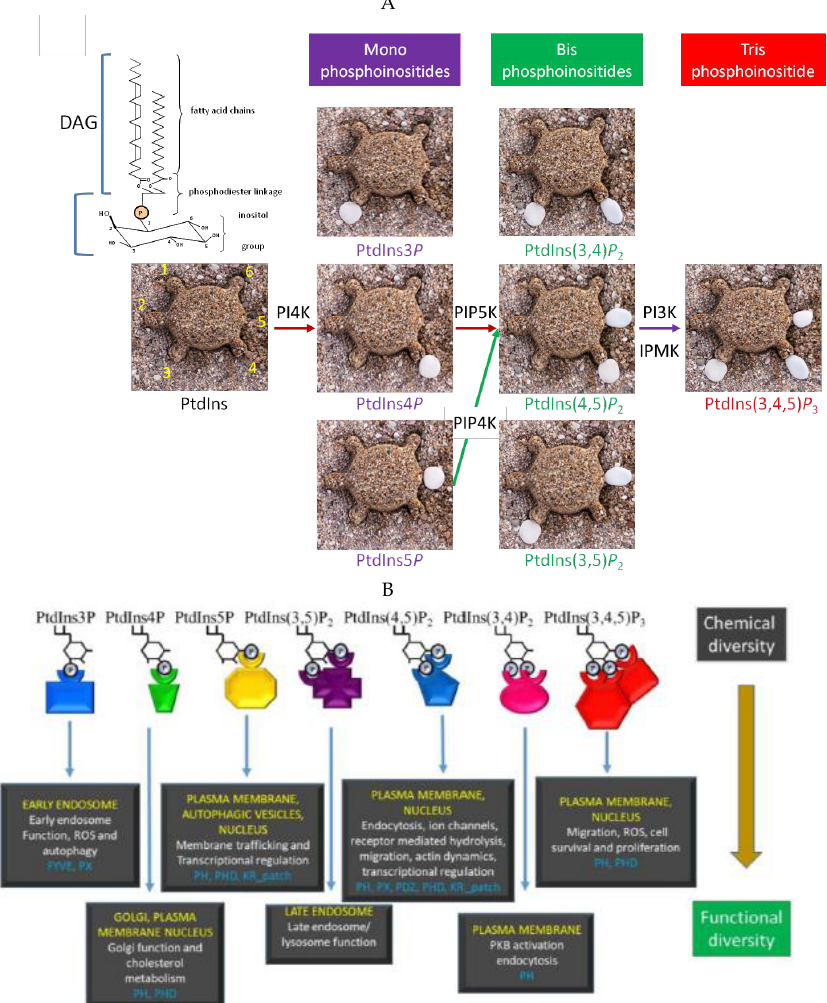
Figure 1. ( A ) The cartoon shows a representation of the parent phosphoinositide phosphatidylinositol, which can be phosphorylated on the 3, 4, 5 position of the head group to generate seven di ff erent PPIns. The 2-hydroxyl is shown in its axial conformation and in the turtles is represented by their head. The white pebbles represent phosphorylation sites. The red arrows show the canonical pathway for PtdIns(4,5) P 2 synthesis, while the green arrow shows a minor pathway involving the PIP4K enzymes that phosphorylate PtdIns5 P on the 4 position to generate PtdIns(4,5) P 2 . This pathway regulates both PtdIns5 P and PtdIns(4,5) P 2 levels. The purple arrow shows two pathways that generate PtdIns(3,4,5) P 3 from the phosphorylation of PtdIns(4,5) P 2 . The IPMK pathway is not inhibited by classical PI3K inhibitors. ( B ) The seven PPIns recruit and regulate a panel of di ff erent downstream e ff ectors to illicit di ff erential outputs. In yellow are examples of subcellular compartments in which these lipids are known to function, while white refers to some of the functions they regulate. Examples of the types of domains each PPIns has been found to interact with are shown in blue. The chemical diversity of phosphoinositides through interaction with these binding proteins e ff ectively transduces them into functionally diverse